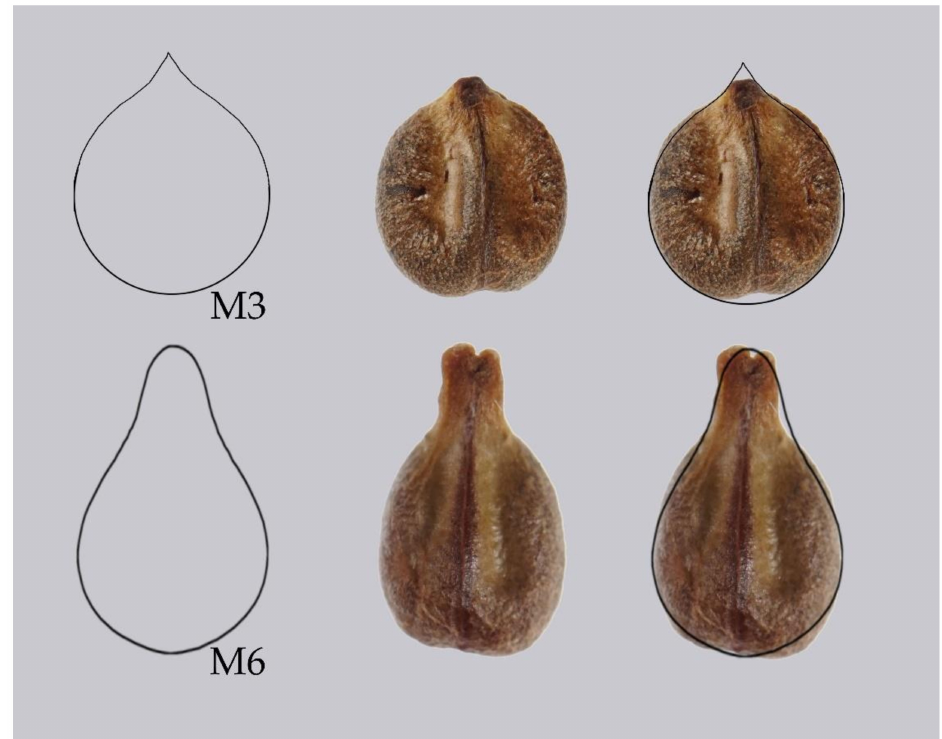
Figure 3. The application of geometric models to seeds of the Vitaceae for the calculation of the J index. Left: two of the models used. Above: seeds of V. amurensis adjust well to M3. Below: Seeds of V. vinifera ssp. vinifera cultivar Morenillo adjust well to M6.